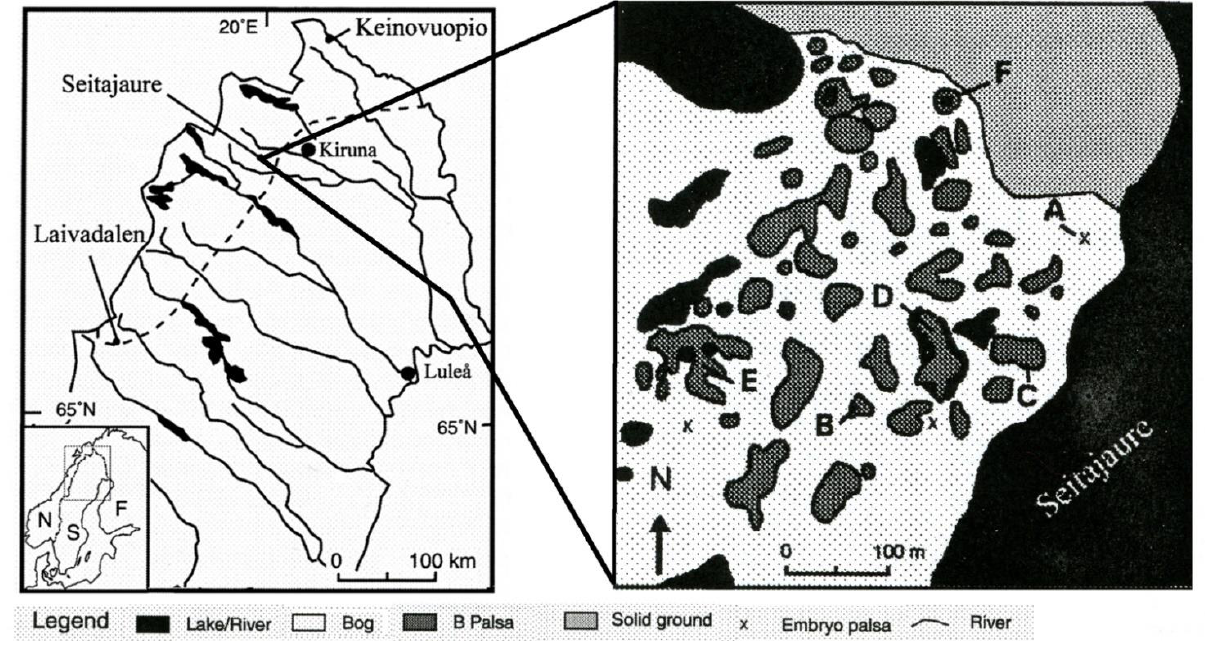
Figure 3. Map of the palsa mire in Seitajaure, Sweden. After Zuidhoff & Kolstrup